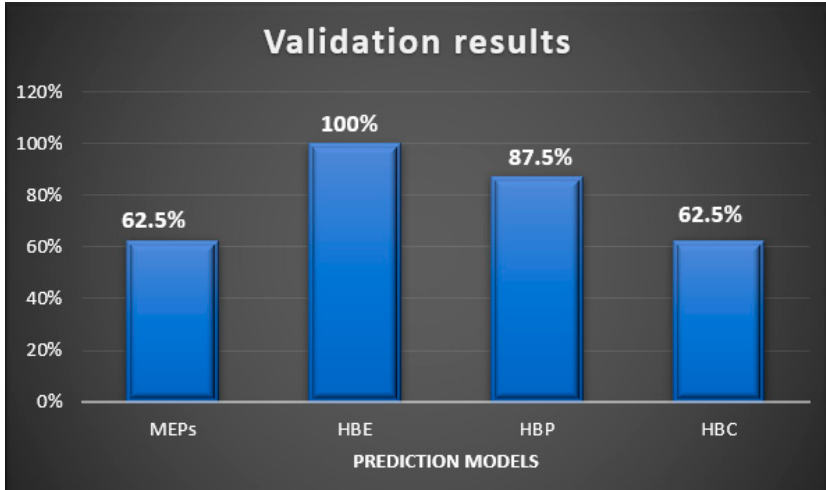
Figure 13. Validation results of supermolecular synthons observed in the pyrazole analogues using four different prediction models